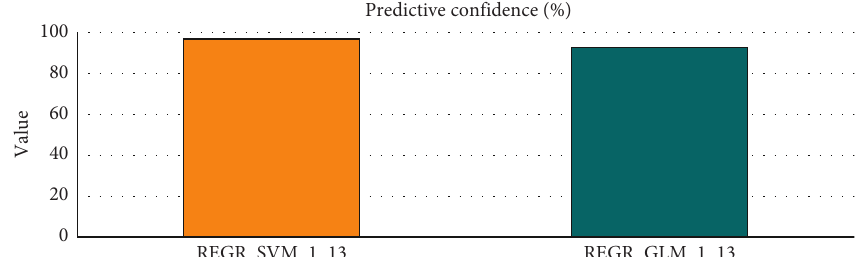
Figure 6: Predictive confidence (%) comparison results for one control parameter.